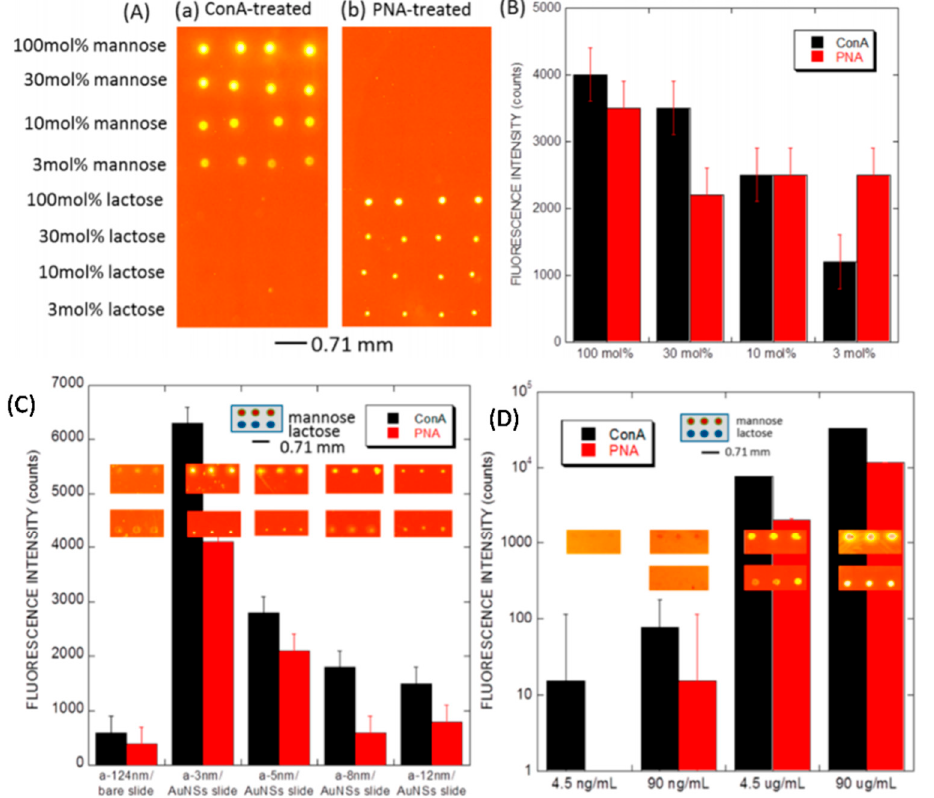
Figure 12. ( A ) Fluorescence images arrays spotted after interaction with ( a ) Con A(0.9 mg/mL) and ( b ) PNA (0.9 mg/mL). ( B ) Histogram of corresponding fluorescence intensity for diluted glycan spots. ( C ) Fluorescence histogram curve for spotted arrays with 100% lactose and 100% mannose after interaction with ConA and PNA (with a fluorescence exposure time of 2 s) followed by PBS rinse ( D ). Fluorescence histogram for spotted 3 nm thick Si 0.8 C0.2:H Au nanostructure array with 100% lactose and 100% mannose after ConA and PNA interaction (fluorescence exposure time of 5 s) followed by PBS rinse. Reproduced with permission from